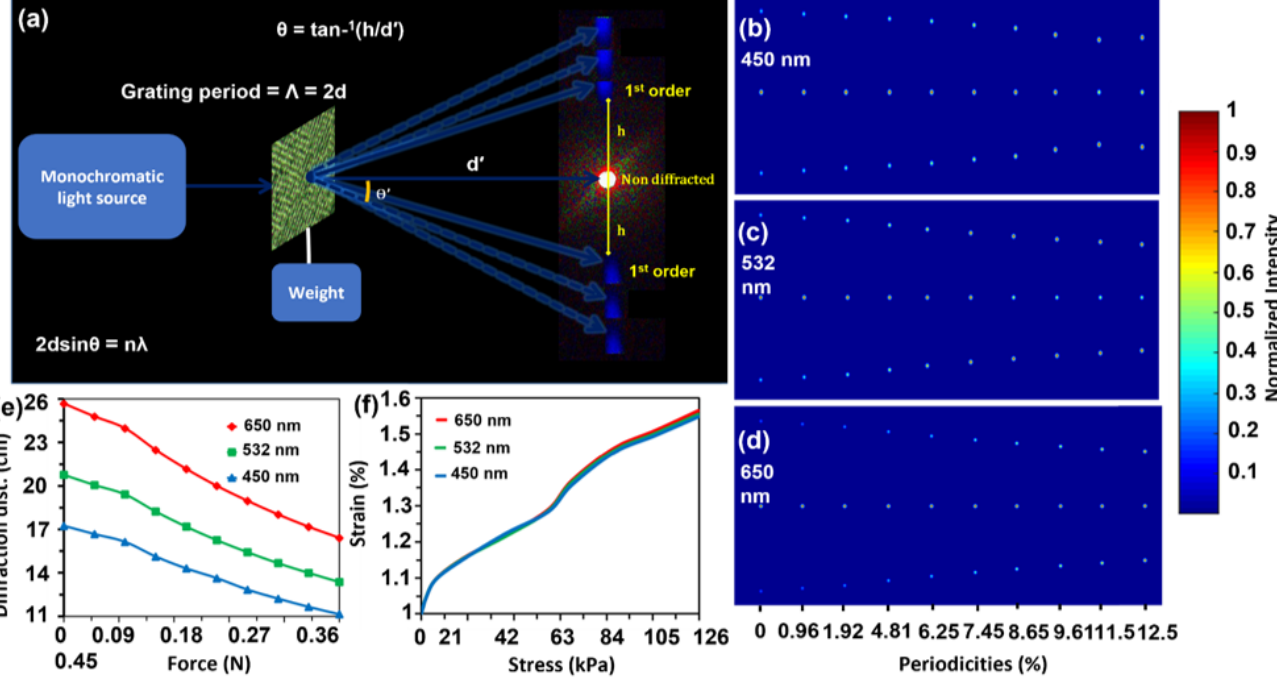
Figure 3. Experimental setup for optical characterization and simulations. ( a ) Schematic of the apparatus setup to perform optical characterization of the polymerized samples; ( b – d ) diffraction angles (degree) of the diffracted spots through different periodicities of the periodic gratings (i.e., left to right are for finer to gradually increasing grating spacing) under blue (450 nm), green (532 nm) and red (650 nm) normal illuminations, respectively. ( e ) Plots of diffraction angles against various stress levels under various incident lights ( f ) stress versus strain curves for red (650 nm), green (532 nm), and blue (450 nm) light illuminations.